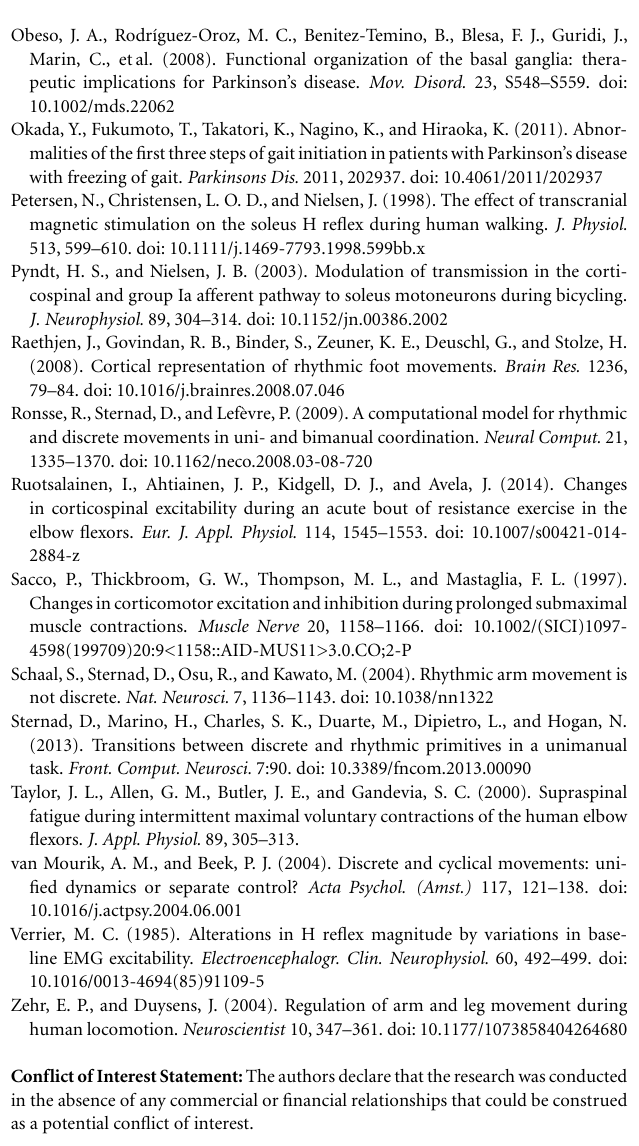
Received: 12 March 2014; accepted: 14 July 2014; published online: 30 July 2014. Citation: Goto Y, Jono Y, Hatanaka R, Nomura Y, Tani K, Chujo Y and Hiraoka K (2014) Different corticospinal control between discrete and rhythmic movement of the ankle. Front. Hum. Neurosci. 8 :578. doi: